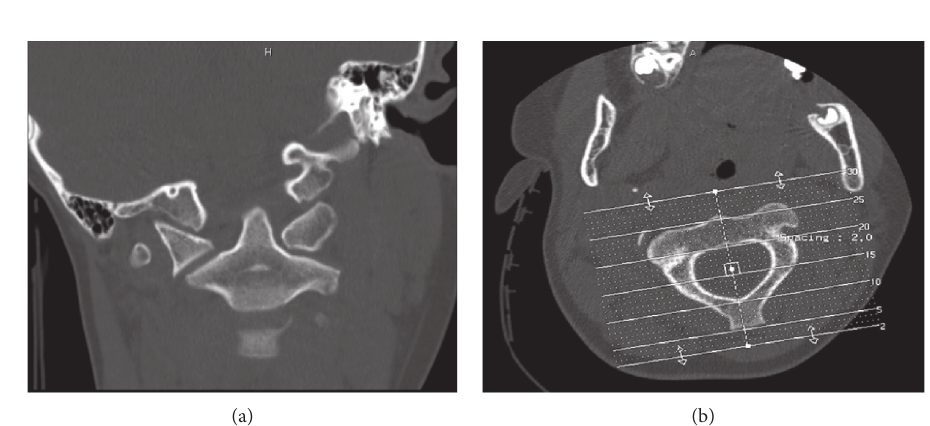
Figure 1: CTscans of our patient 1. (a) The anteroposterior view shows the asymmetry of the lateral masses of the atlas with respect to the axis. (b) The transversal view shows the rotation of the atlas on the axis.